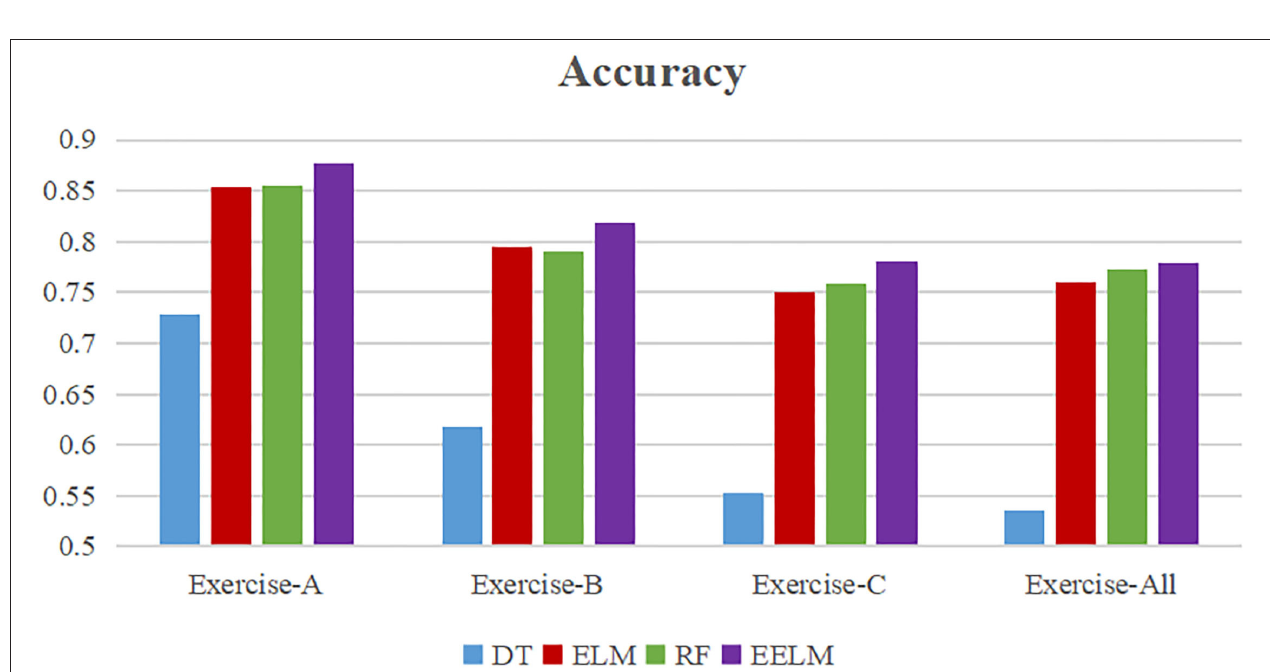
FIGURE 8 | Overall average classification accuracy